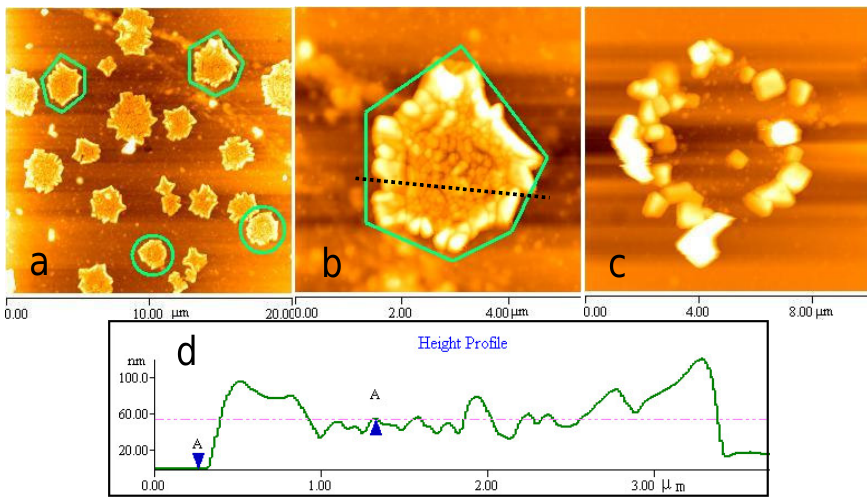
Figure 5. The AFM images of lyotropic liquid crystals of chitosan. Figure a, b are images obtained as soon as chitosan dropped on mica; Figure c is the images obtained at 16 h. Figure d is the height profile generated along the broken line in Figure 5b, the diameter is 2.971 µ m, and the thickness is 52.34 nm (the difference between two arrowheads in Figure 5d).